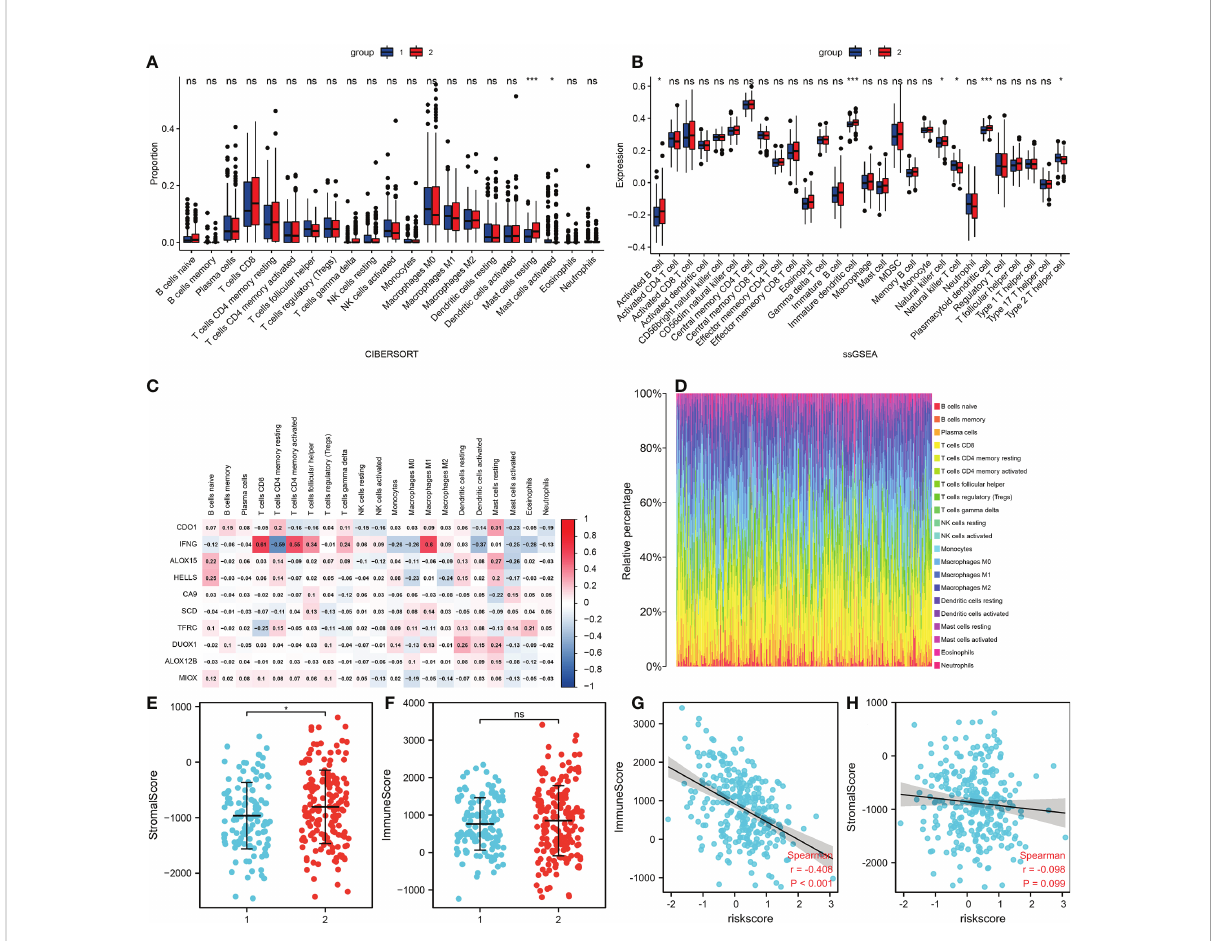
FIGURE 6 Differences in the tumor microenvironment. (A) The in fi ltration levels of 22 immune cell subtypes in the high and low risk groups. (B) Quantitation of distinct immune cell subsets using ssGSEA. (C) The correlation between 10 FRGs and immune cells. (D) Immune cell proportions for each tumor patient. (E) Relationship of stromal scores between the two groups. (F) Relationship of immune scores between the two groups. (G) Correlations between risk and immune scores. (H) Correlations between risk and stromal scores. *p<0.05 ***p<0.001 Ns: no signi fi